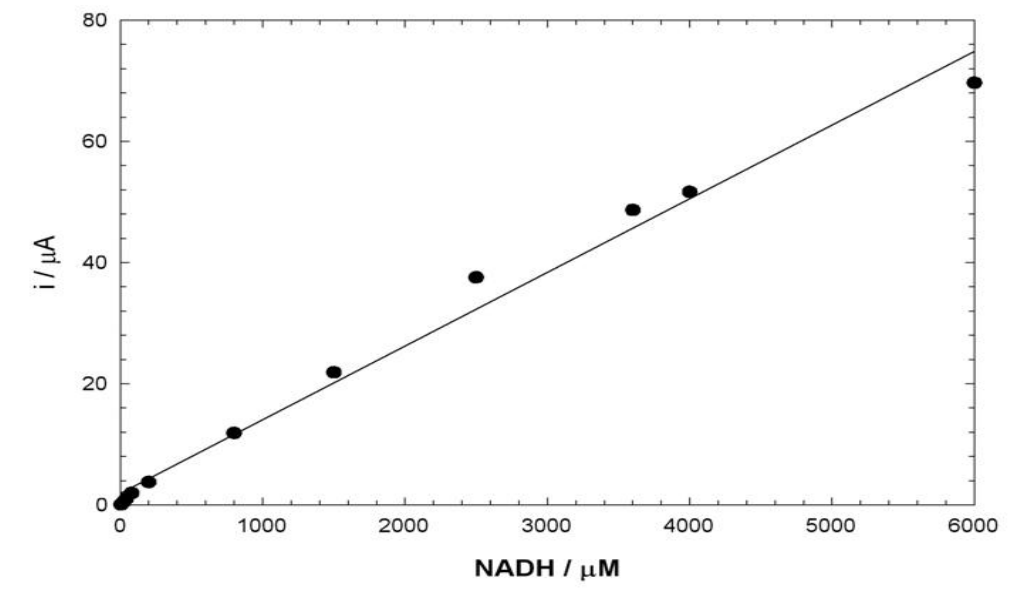
Figure 5. Calibration curve for NADH